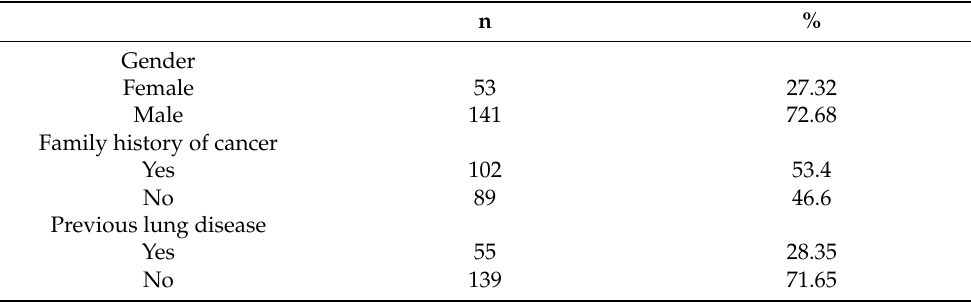
Table 2. Classification of the 194 NSCLC patients according to the clinico-pathologic characteristics.